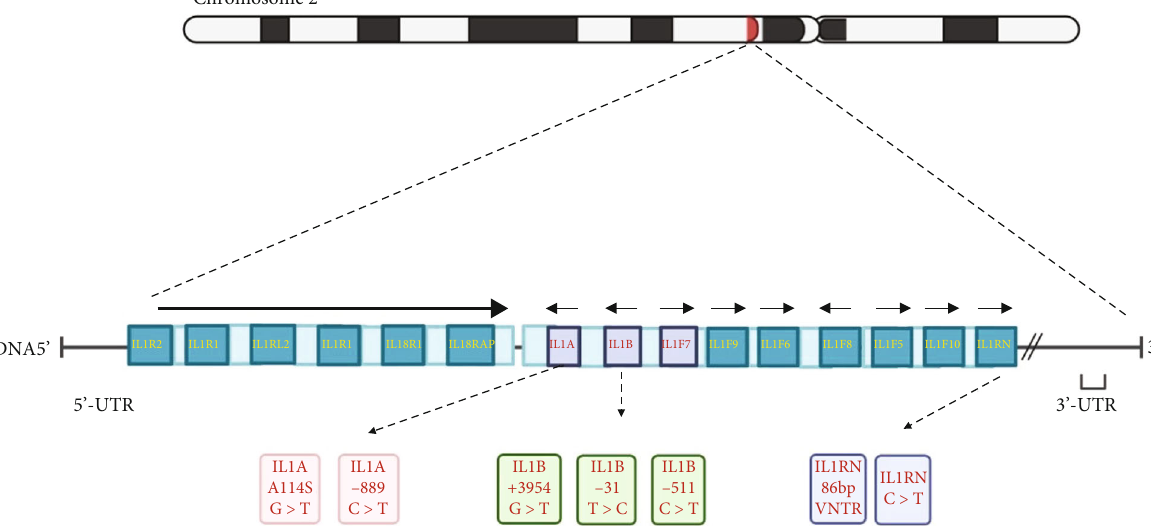
Figure 2: Map of IL-1 gene clusters on chromosome 2. Putative functional SNPs are annotated for IL1A, IL1B, and IL1RN (https:// Biorender.com, modi fi ed) [124,